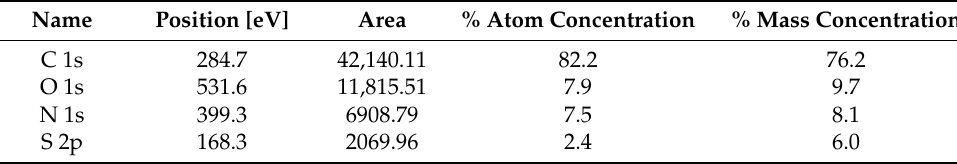
Table 6. The elemental composition determined for Dowex M